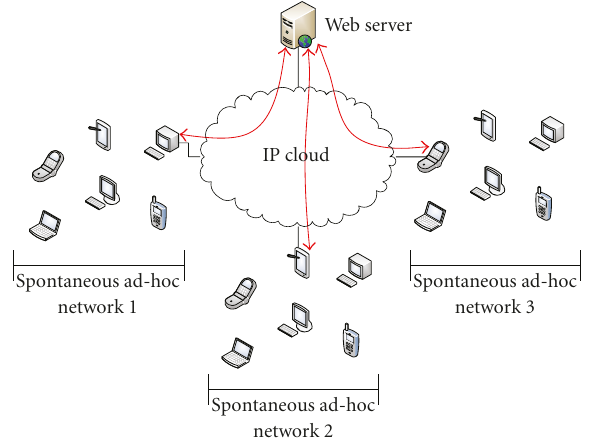
Figure 8: Simulated network diagram.